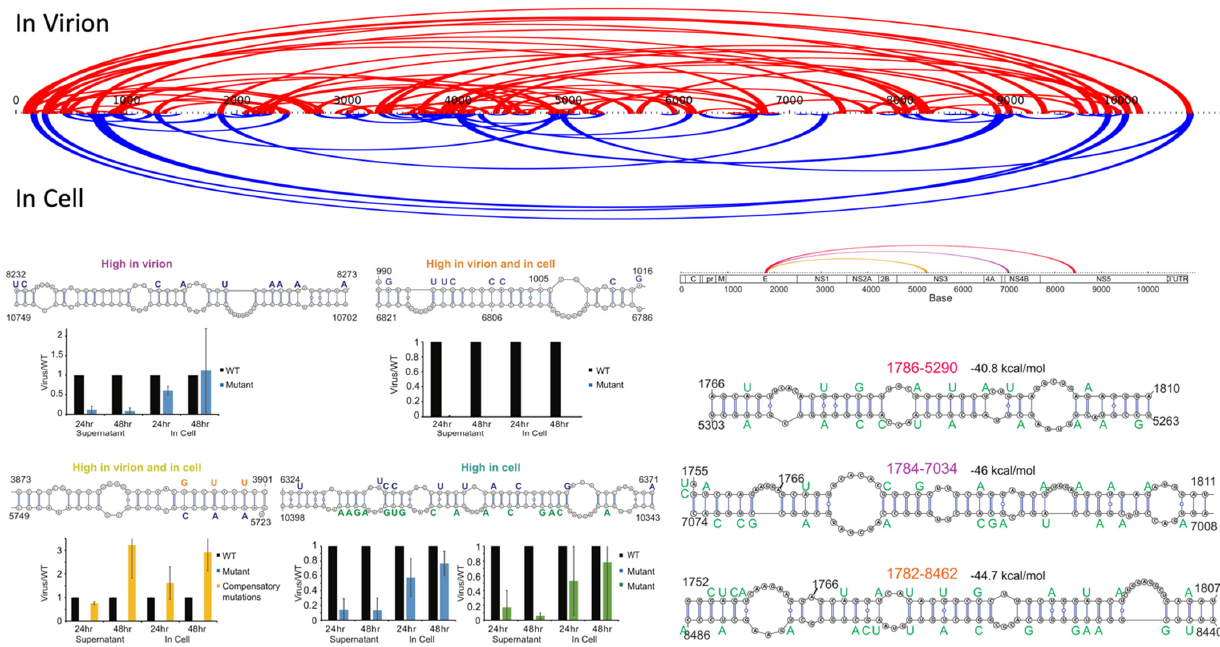
Figure 2. Internal circularization sites of DENV-1 genome, as determined by SPLASH cross-linking [19]. It is apparent that the number of internal circularization motifs in virions (red) is much higher than those identified in infected cells. A number of interactions persist in cells (blue). This may be attributed to the spatial constraints imposed by the virion shell or it may be a prerequisite for packaging. Functional assays demonstrate the importance of these motifs for viral fitness, with structure-disrupting changes causing a pronounced drop in viral activity. Compensatory mutations restore viral fitness. Several of the identified internal circularization sites show multiple interaction partners in the SPLASH experiment and structure models of the relevant regions show competing base pairs among the possible partners. It is currently unclear whether these competing interactions form in a stochastic manner or whether specific interactions are present at different stages of the viral life cycle and/or rearrange